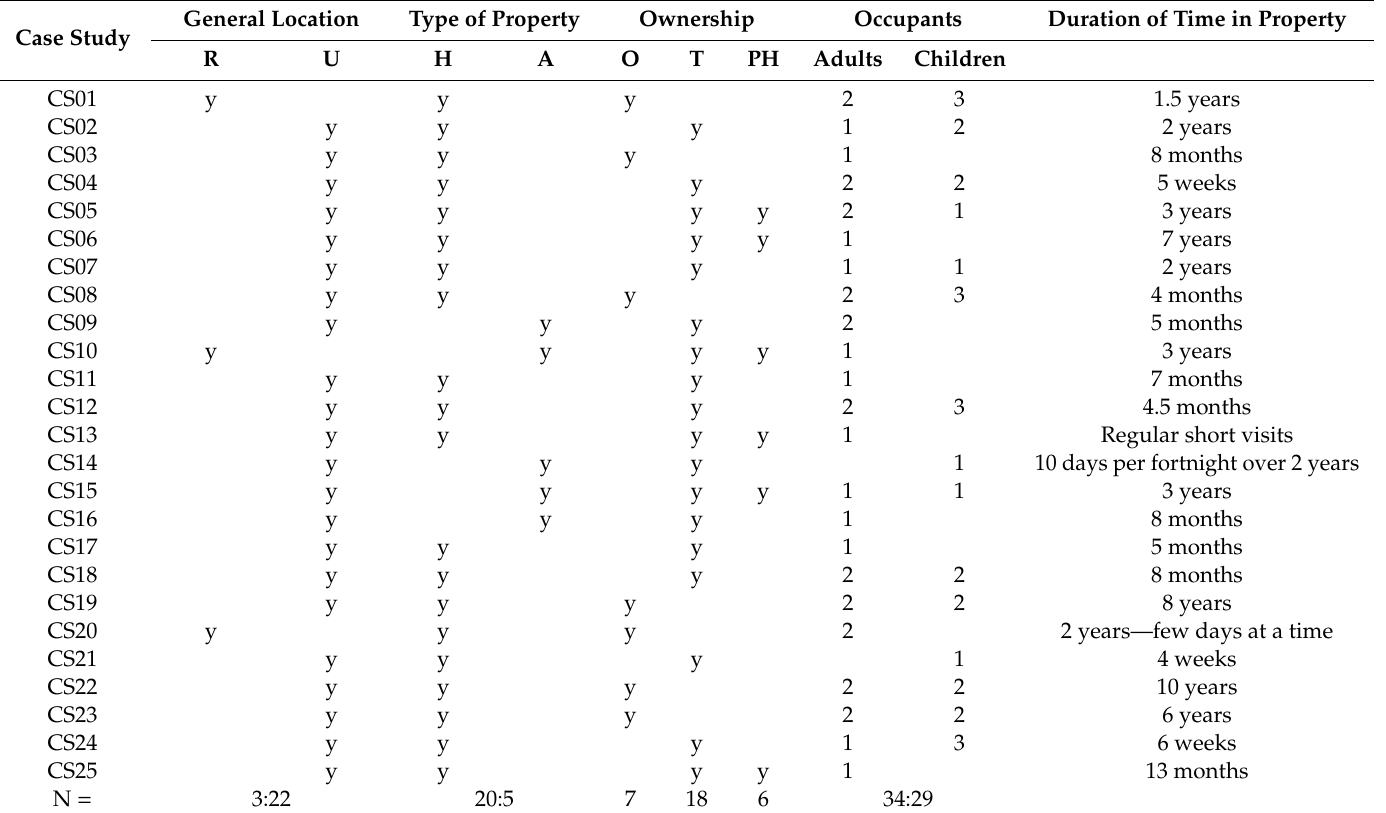
Table 1. Summary of key aspects associated with case